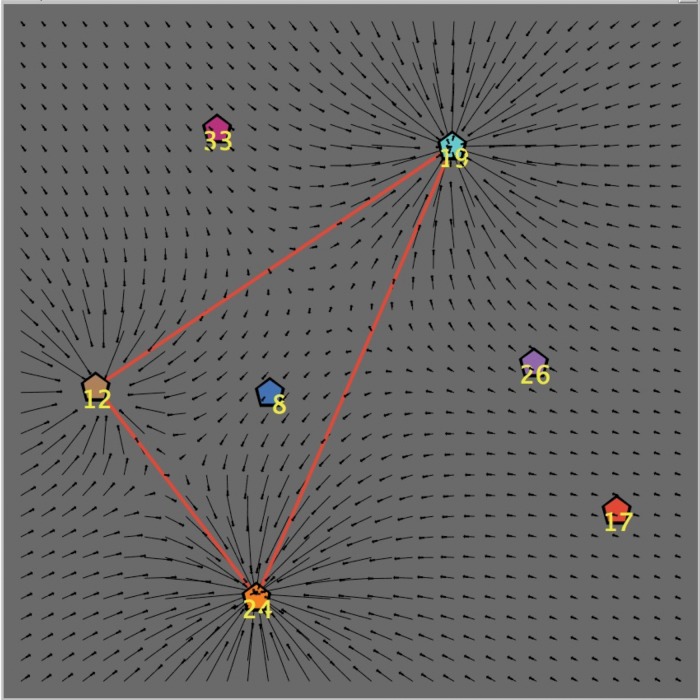
Market-consumer interaction: attraction field induced by three active hubs.The label next to each hub represent its mass, which is equal to the number of products (leaves) of the corresponding cluster. All intermediate and terminal nodes are not represented.